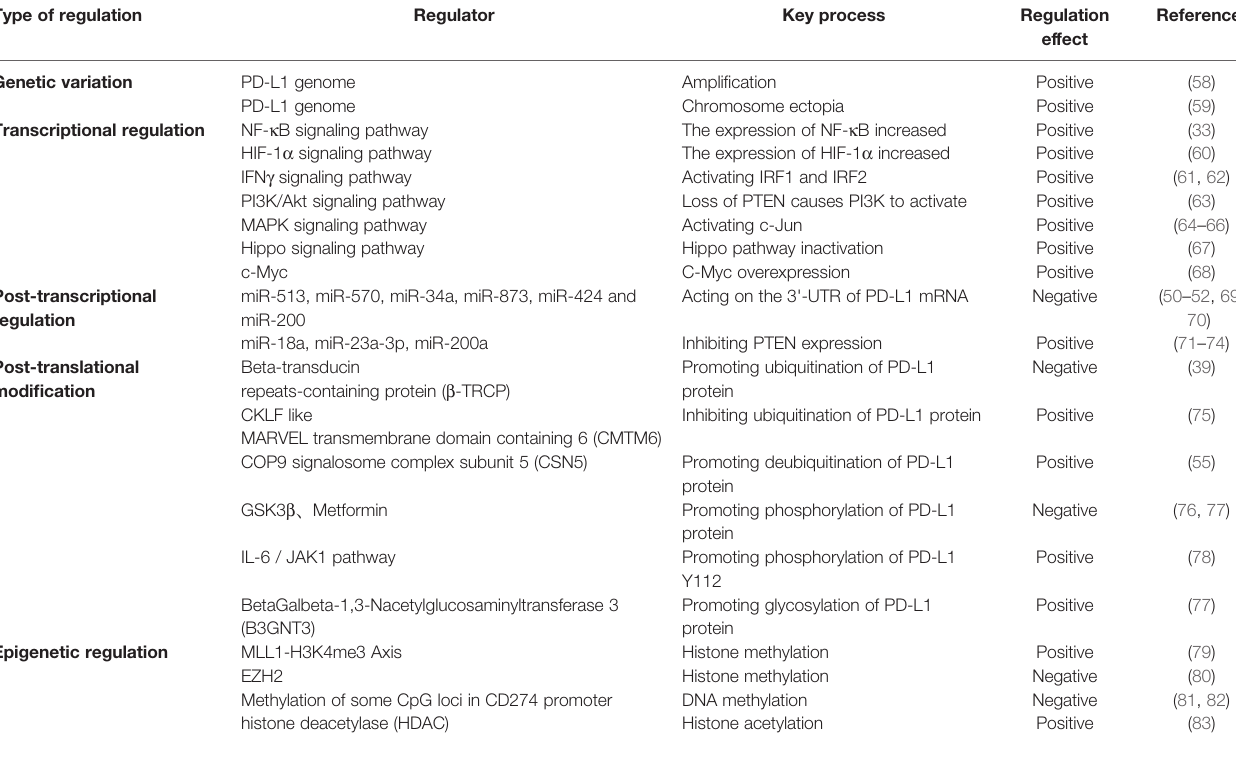
TABLE 2 | Regulation mechanism of